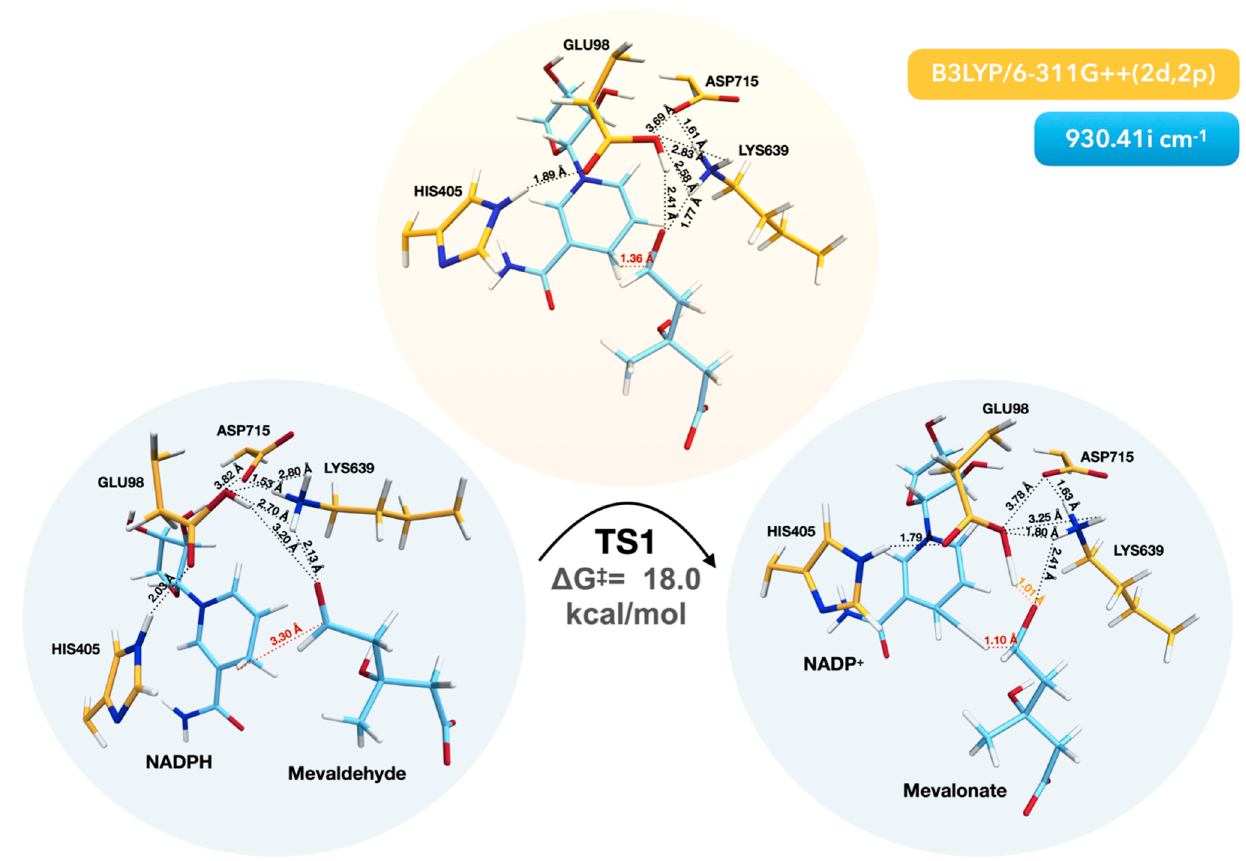
Figure 3. Reaction mechanism for a system with neutral His405 with corresponding imaginary frequency and distances between atoms important for reaction. All three structures represent optimized structures and the imaginary frequency corresponds to the TS. The reaction coordinate followed was marked in red, whereas newly formed bonds are marked in orange. After the hydride transfer and the protonation by Glu98, mevalonate is formed.